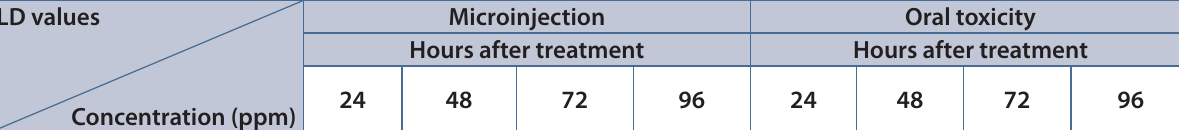
LC and LC (ppm) of 30, 50 90